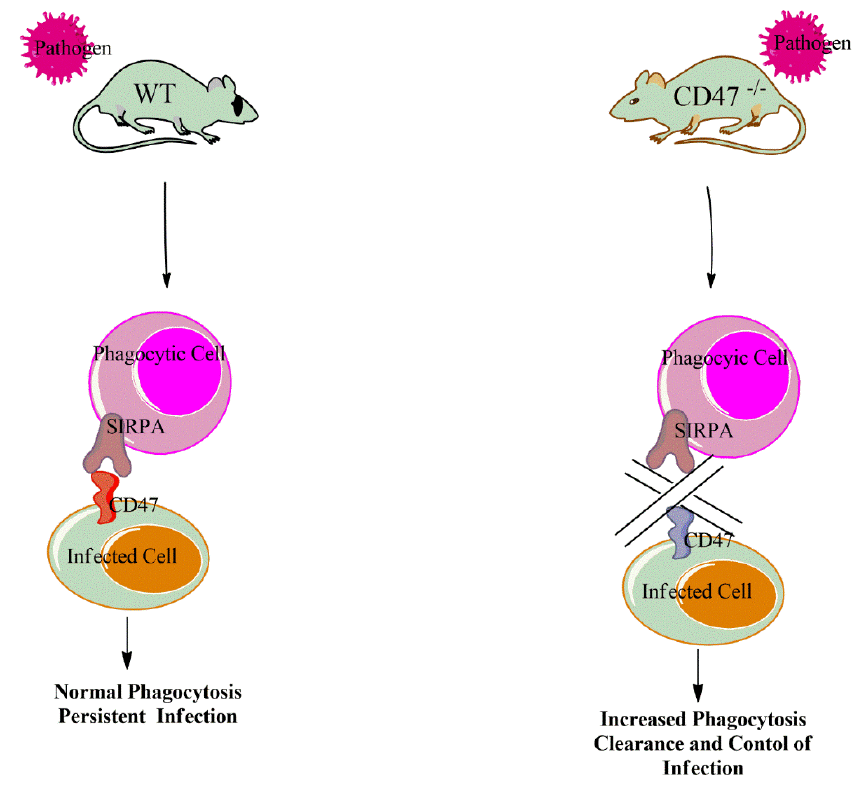
Figure 1. Interaction of CD47-SIRPa following an infection limits the phagocytosis of infected cells (e.g., plasmodium-infected red blood cells (RBCs)) and result to persistence of infection. On the contrary, the genetic inactivation of CD47 leads to an increased phagocytosis of (e.g., plasmodium ) infected cells and faster control of infection.